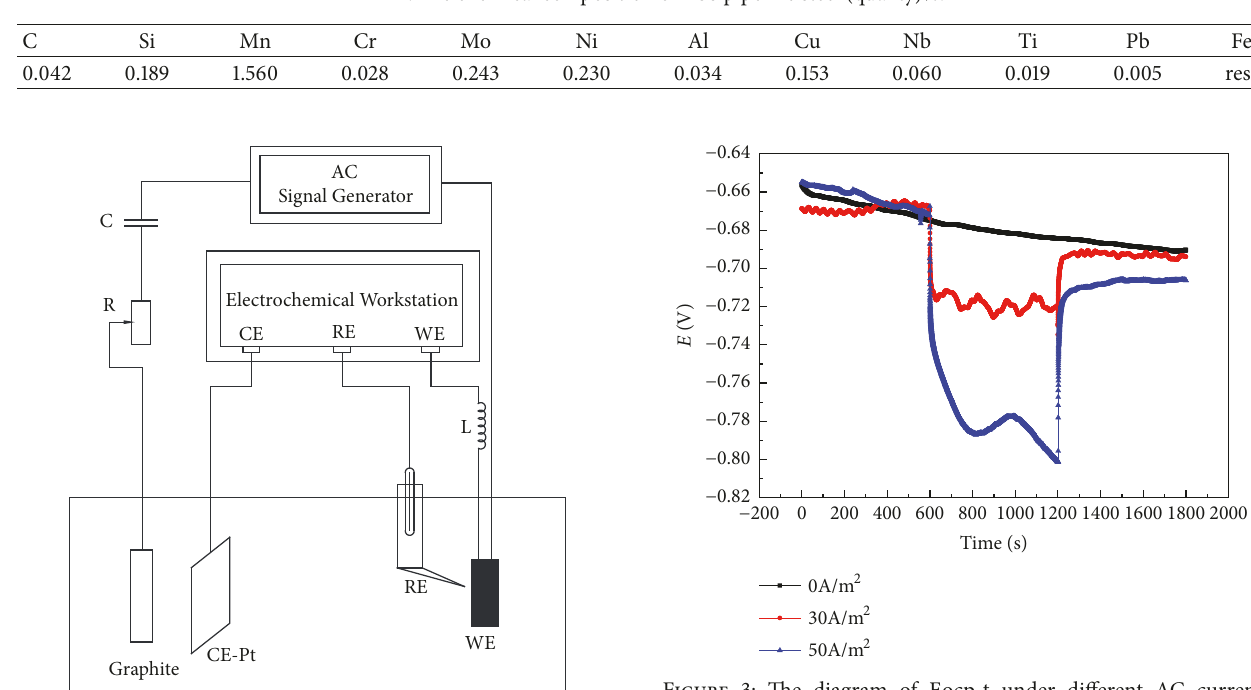
Figure 3: The diagram of Eocp-t under different AC current